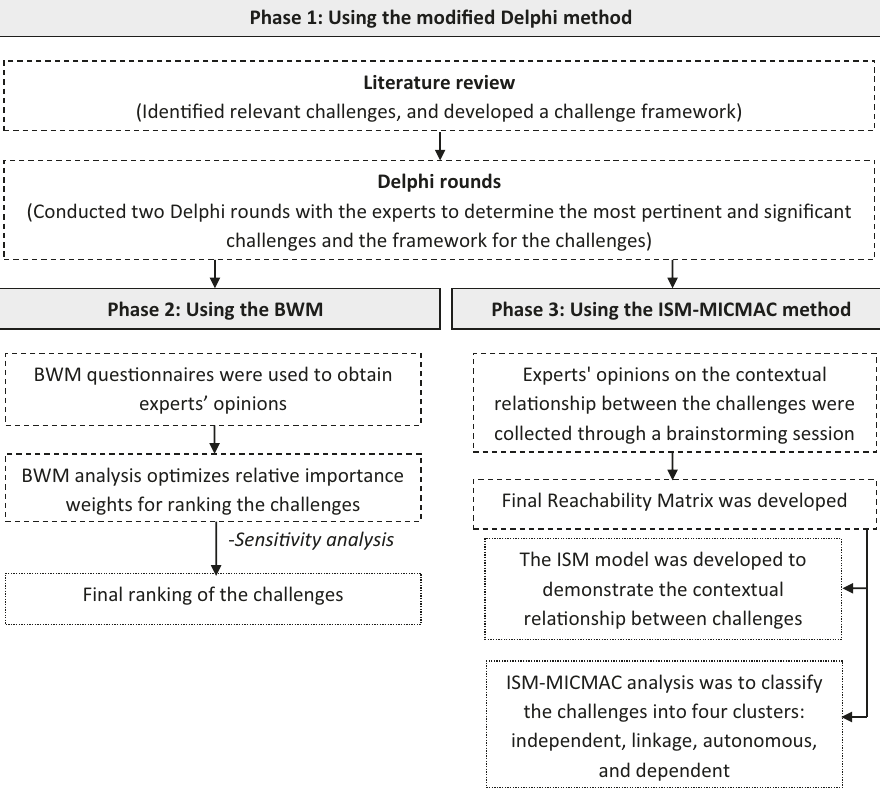
Fig. 3 Methodology. A fl ow chart of research methodologies applied in this